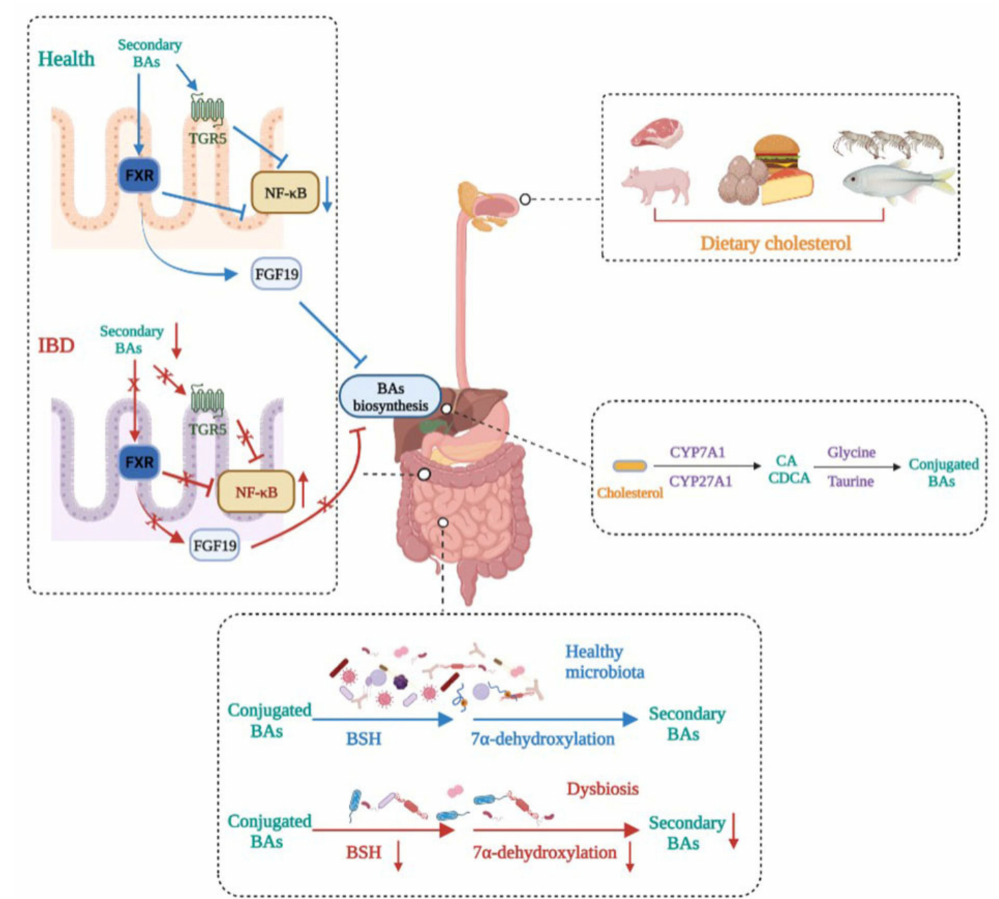
Figure 3. Bile acid metabolism disturbance in IBD. BA metabolism is altered in IBD patients. Dietary cholesterol is digested and absorbed in the gastrointestinal tract. Cholesterol is biotransformed to conjugated primary BAs in the liver and then secreted in the gut. Gut microbiota dysbiosis in IBD impairs BSH activity and 7 α -dehydroxylation, leading to decreased secondary BAs. This induces decreases in the expressions of FXR and TGR5, which makes the transcription of NF- κ B relevantly enhanced, thus aggravating IBD severity. In addition, decreased secondary BAs caused by dysbiosis reduce the production of FGF19, leading to primary BA accumulation in the